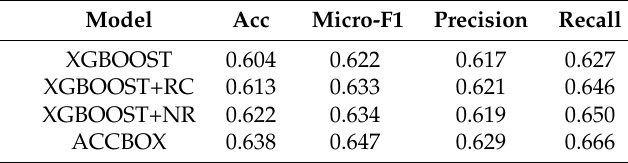
Table 3. Ablation study of contributions of different modules.